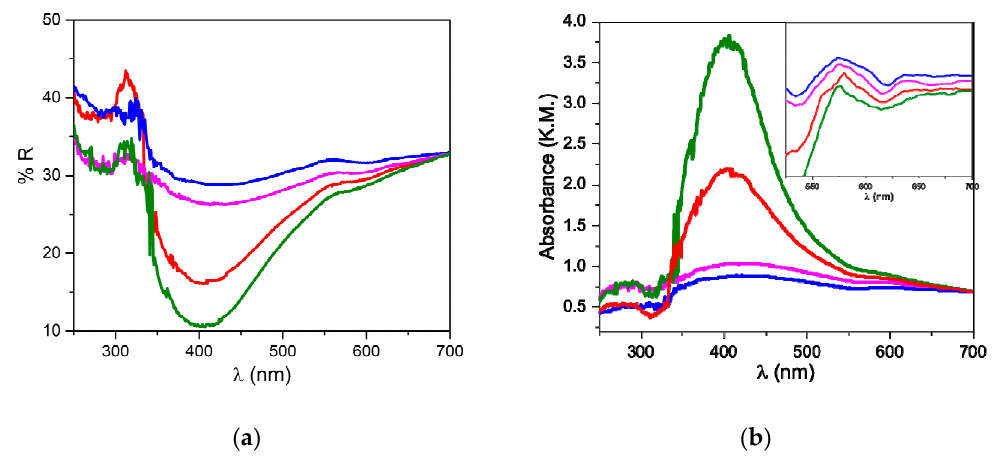
Figure 2. UV–Vis reflectance ( a ) and absorption ( b ) spectra (in Kubelka–Munk units) of US50B (red line), US100B (green line), US50C (blue line), and US100C (pink line); Inset first derivative of the absorption spectrum.